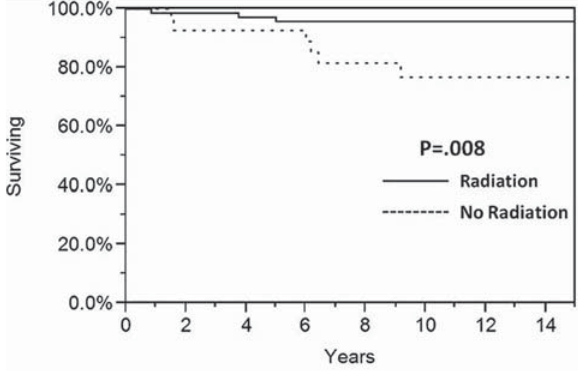
Figure 1 - Overall survival for stage IIA testicular seminoma patients managed with radiation therapy vs. other approaches.